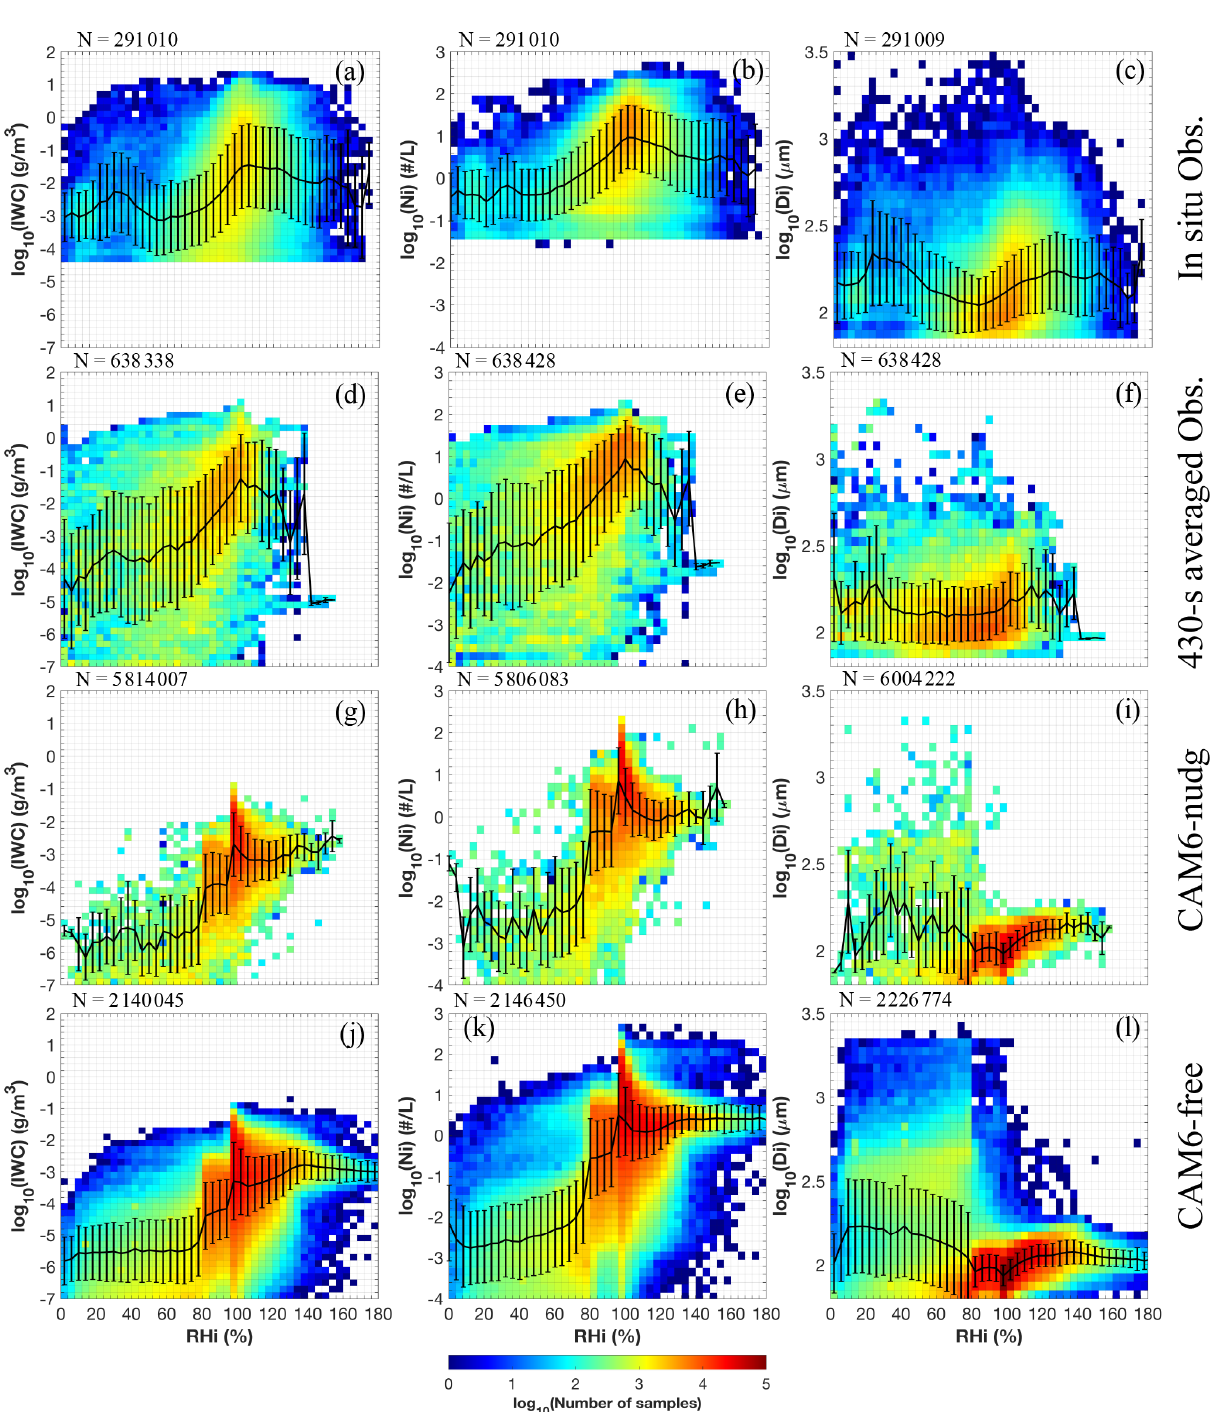
Figure 13. Correlations between RHi and in-cloud IWC, N i and D i (columns 1–3, respectively), compared among (a–c) in situ 1Hz obser- vations, (d–f) 430s averaged observations, (g–i) CAM6-nudg and (j–l) CAM6-free data. Black lines and whiskers denote geometric means and standard deviations,